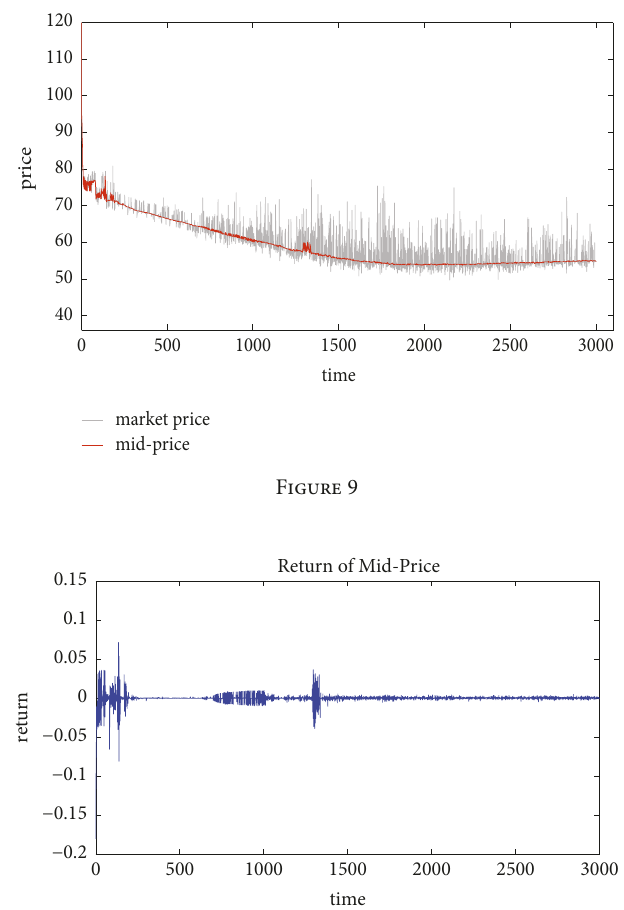
Figure 10: Logarithmic return series of the